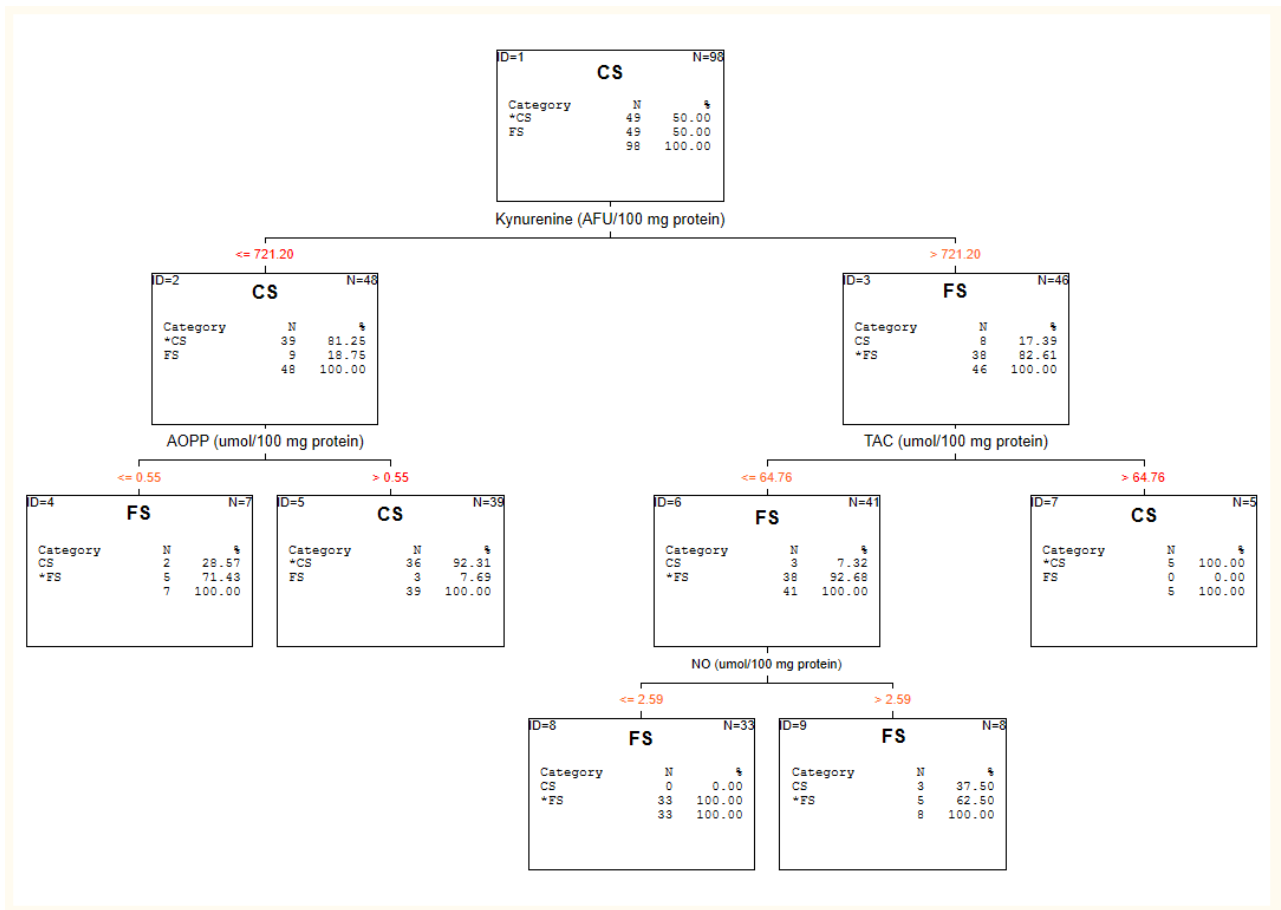
Figure 2 . C&RT analysis for first-episode (FS) and chronic patients (CS). Figure 2. C&RT analysis for first-episode (FS) and chronic patients (CS).